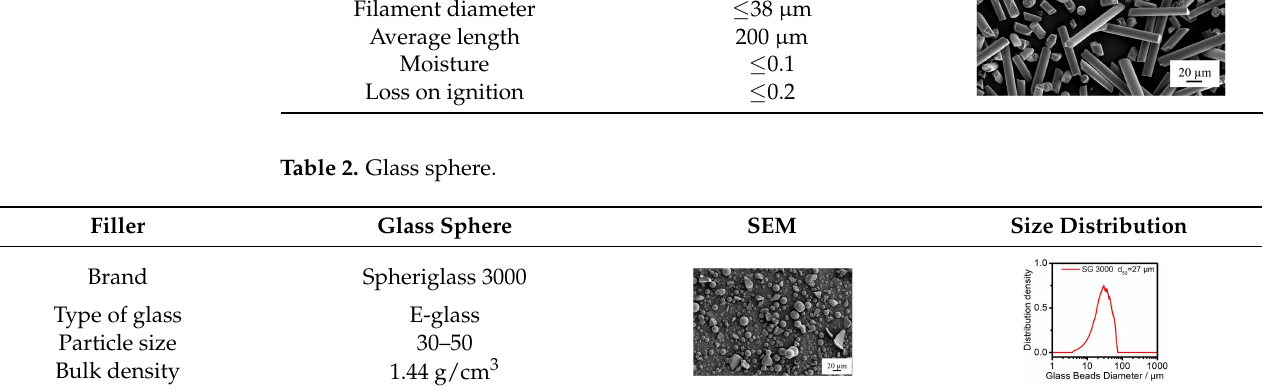
Table 3. Table 3. The composition of the test material (weight percentage). Table 3. The composition of the test material (weight percentage).